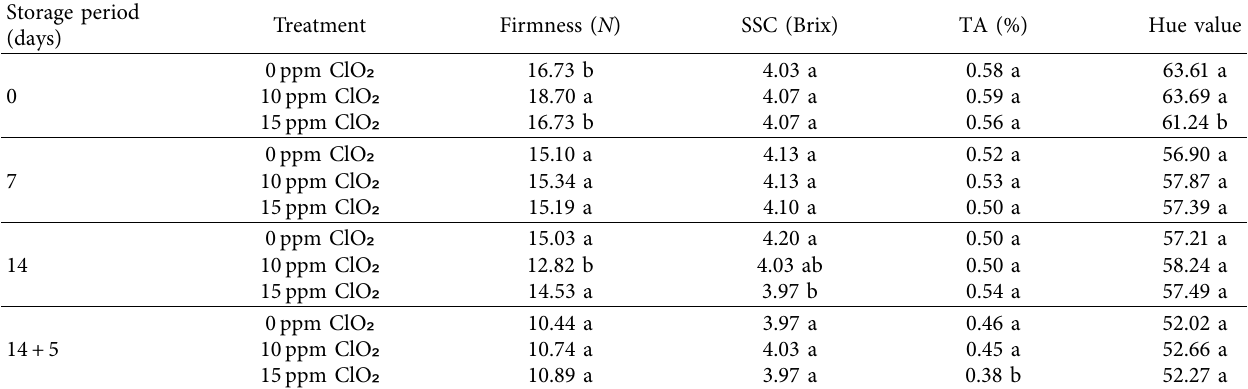
Table 2: Efect of ClO 2 treatment on quality (frmness; SSC : soluble solid content; TA : titratable acidity) and color (Hue values) in tomatoes stored at 4 ° C for 14 days followed by 5 days at 20 °